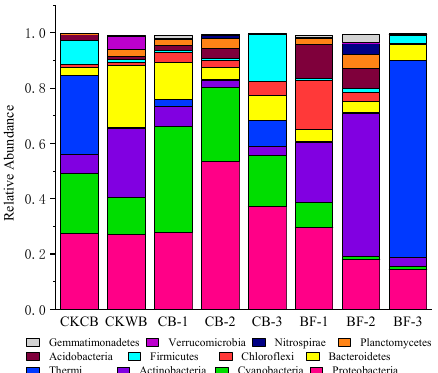
Figure 5. Composition of dominant prokaryote phyla.